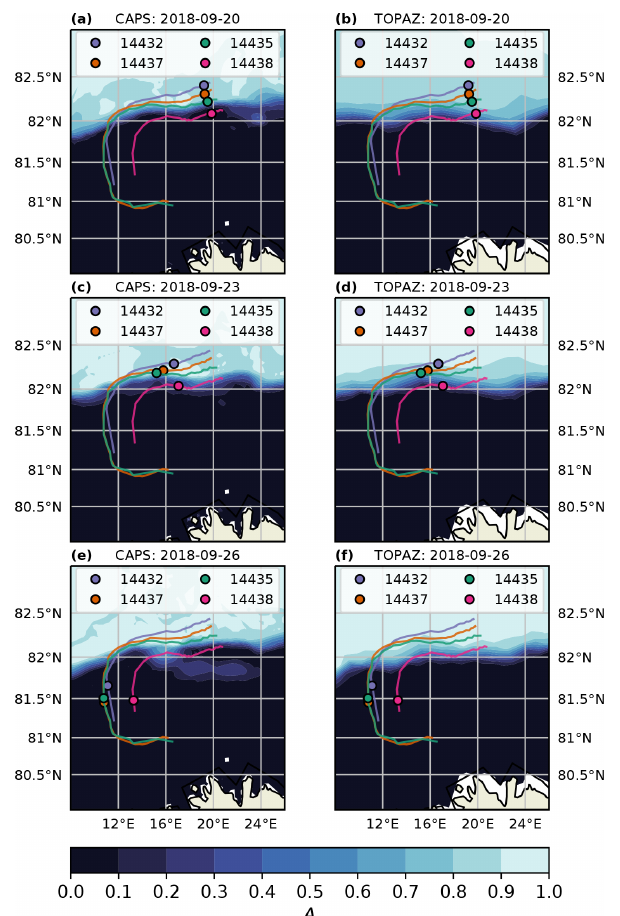
Figure 1. Drifter tracks (–) and locations (o) at three different times during their respective trajectories. Filled contours of ice concentra- tion are shown as calculated by CAPS (a, c, e) and TOPAZ (b, d, f) . Drifter IDs, from furthest in the ice to nearest to ocean, are 14432 (blue), 14437 (orange), 14435 (green), and 14438 (red). Drifters exit the MIZ on approximately 25 September 2018 at